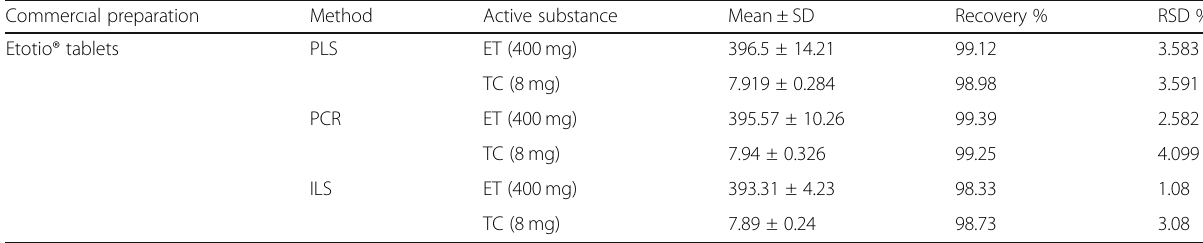
Table 4 Analysis results of ET and TC in commercial mixture products (Etotio® tablets) using the multivariate calibration methods (PLS, PCR, and